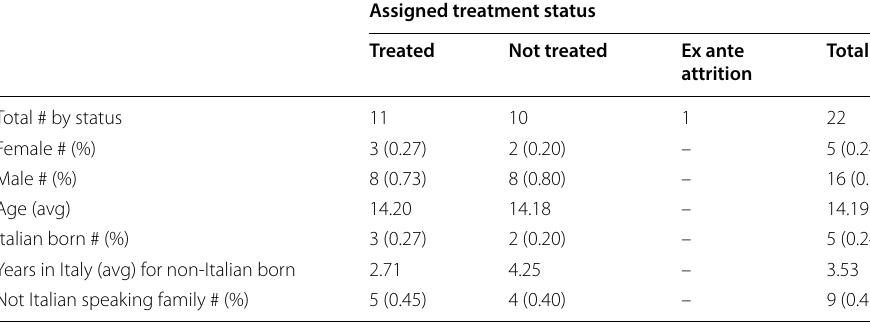
Absolute and percentage